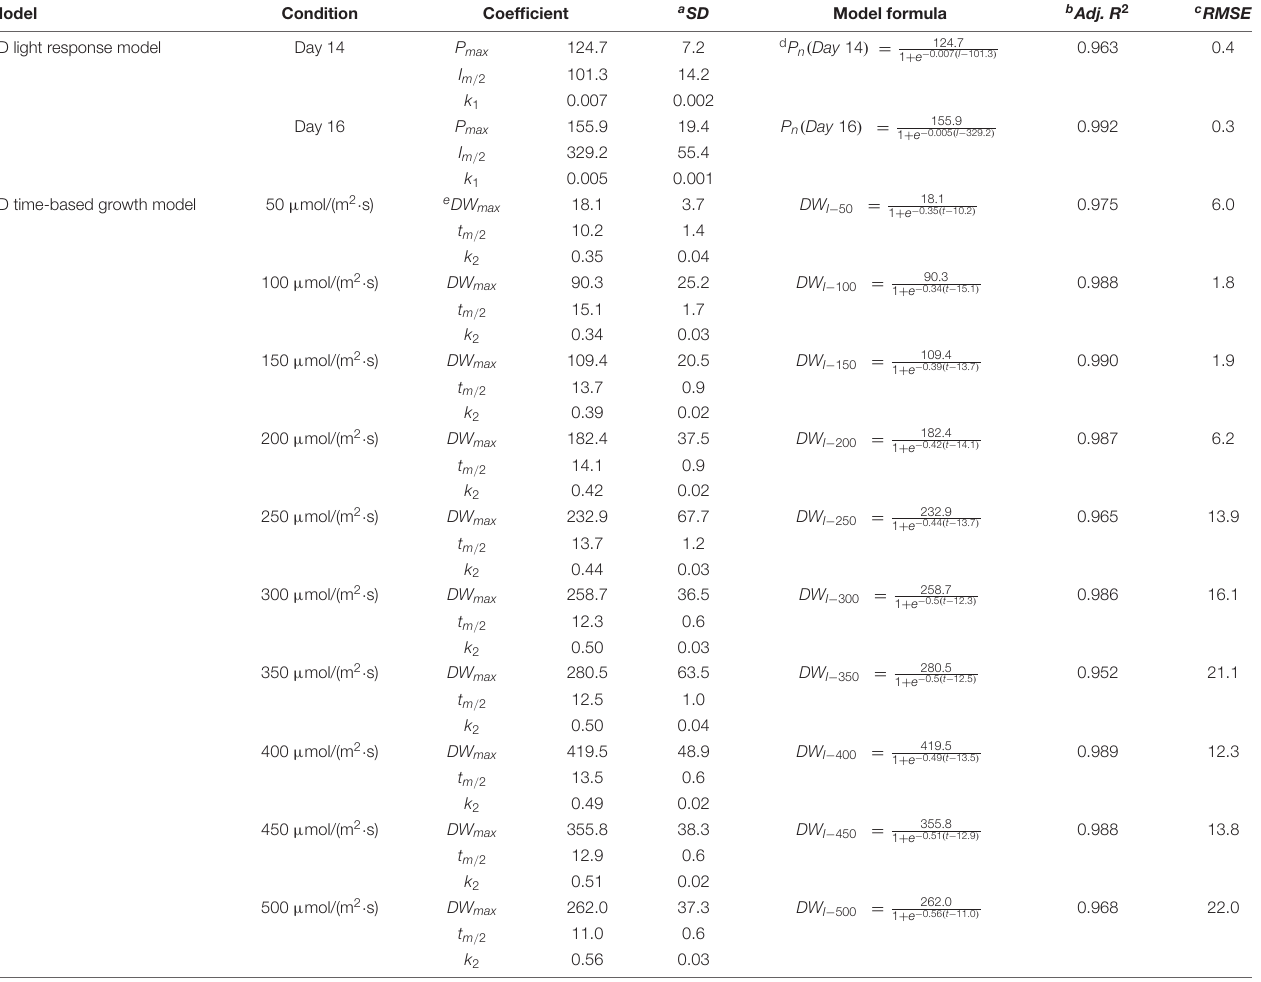
TABLE 4 | The selected 2D light response model and 2D time-based (logistic) growth model of choy sum seedling. Model Condition Coefficient Model formula 2D light response model